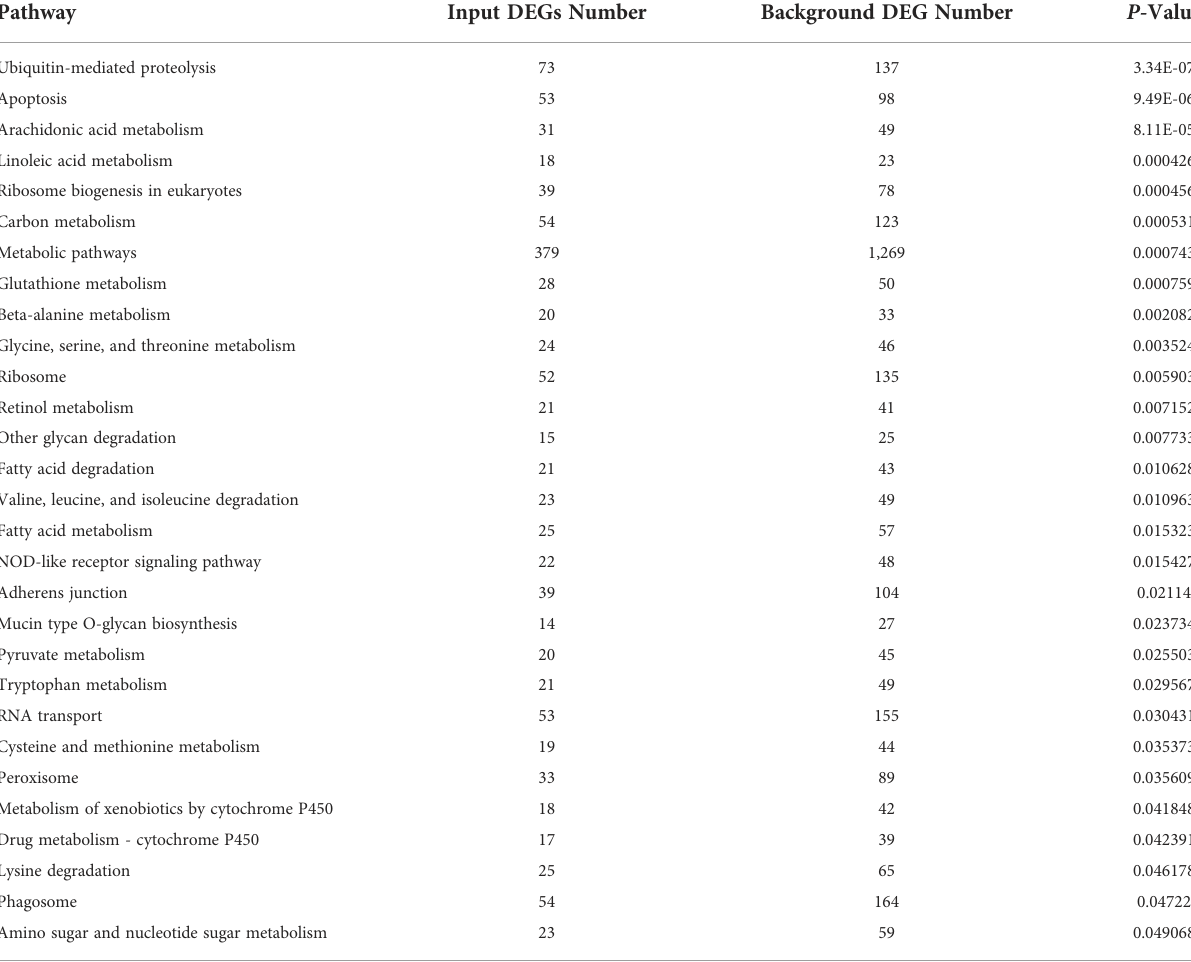
TABLE 4 Signi fi cantly enriched KEGG pathway of DEGs in gills of abalone under Vibrio challenge.